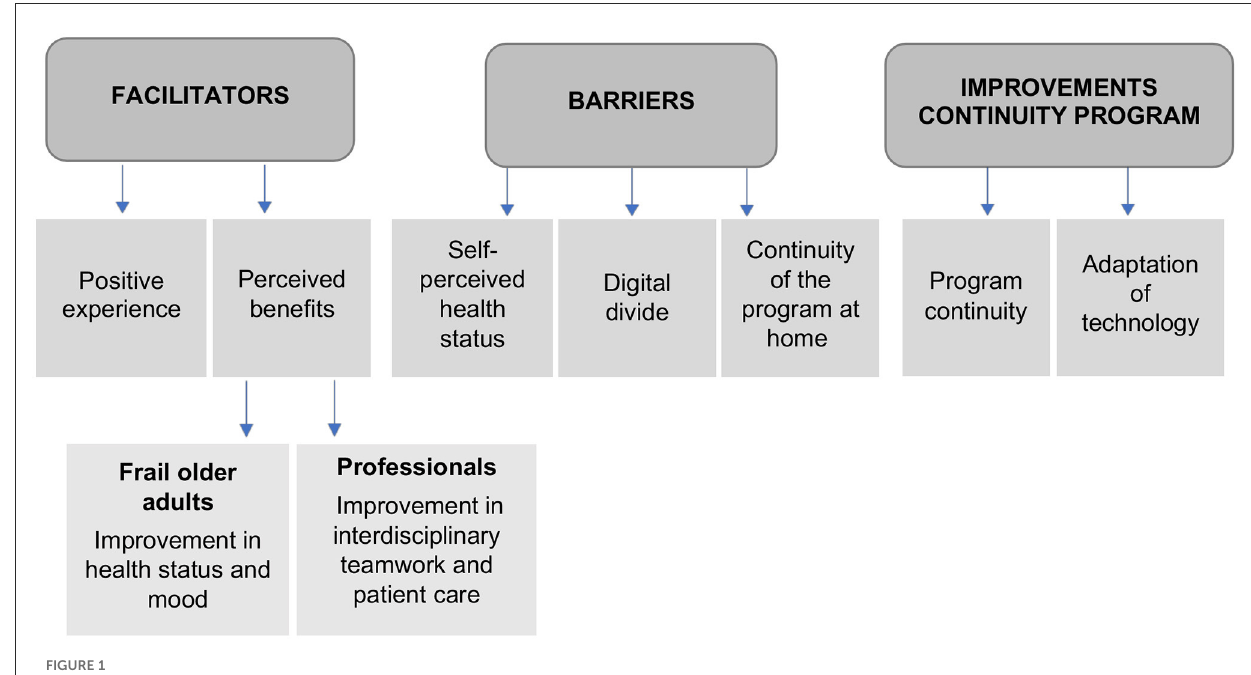
FIGURE1 Themes and